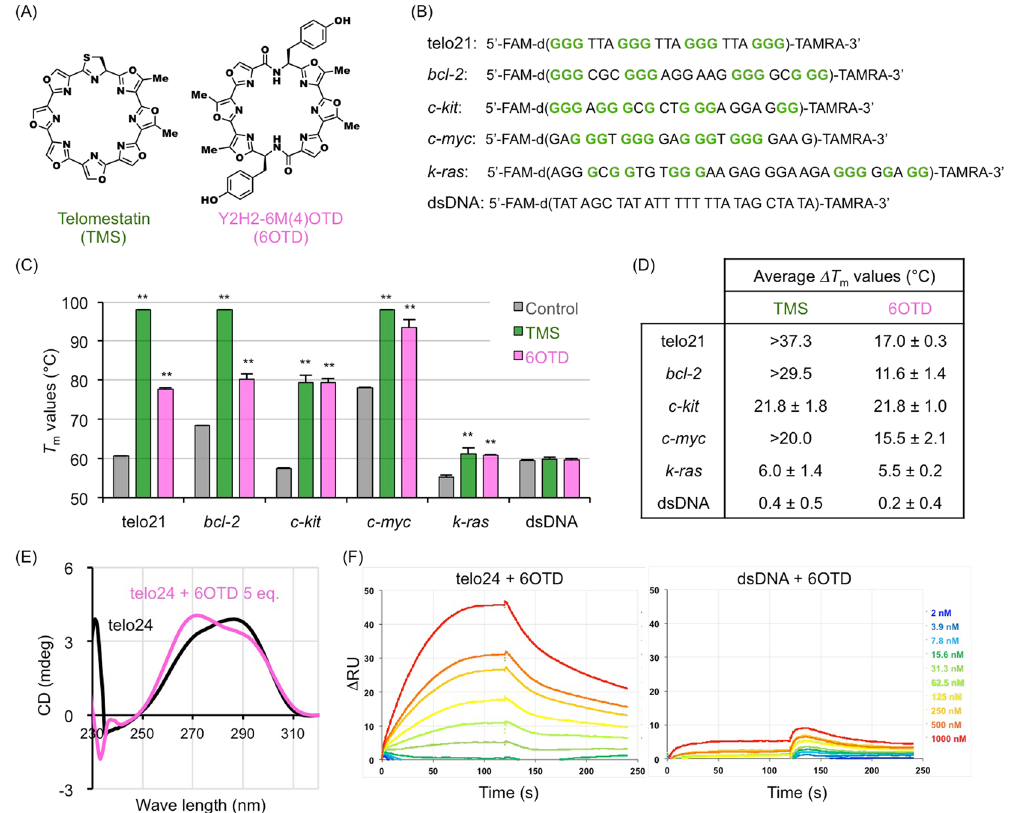
Figure 1. 6OTD stabilizes G4 structures. ( A ) Chemical structures of telomestatin (TMS) and 6OTD. ( B ) List of oligonucleotides used in the FRET melting assay. All oligonucleotides are dual-labeled with FAM and TAMRA at their 5 ′ and 3 ′ ends, respectively. Guanines involved in G4 formation are colored in green. ( C ) T m values of the oligonucleotides (0.2 μ M) determined by the FRET melting assay in the absence or the presence of G4 ligands (1.0 μ M) in K + -rich buffer. Each T m value represents the mean of triplicate assays ( ** P < 0.01). In the presence of TMS, T m values of telo21, bcl - 2 , and c - myc exceeded 98 °C, which was the highest temperature of this measurement. Error bars , standard deviation (SD). ( D ) Δ T m values for TMS and 6OTD against each nucleotide. Each value represents the mean ± SD of triplicate assays. ( E ) CD spectra of the telomeric 5 ′ -d[TTAGGG] 4 -3 ′ (telo24) oligonucleotide in the presence of 100 mM KCl at 25 °C. Concentrations of telo24 and 6OTD were 10 μ M and 50 μ M, respectively. ( F ) SPR analysis of telo24 and dsDNA with 6OTD. K D value for the telo24- 6OTD interaction was 163.7 ± 29.3 nM, determined by three independent experiments. K D value for the dsDNA-6OTD could not be determined due to the low affinity of the